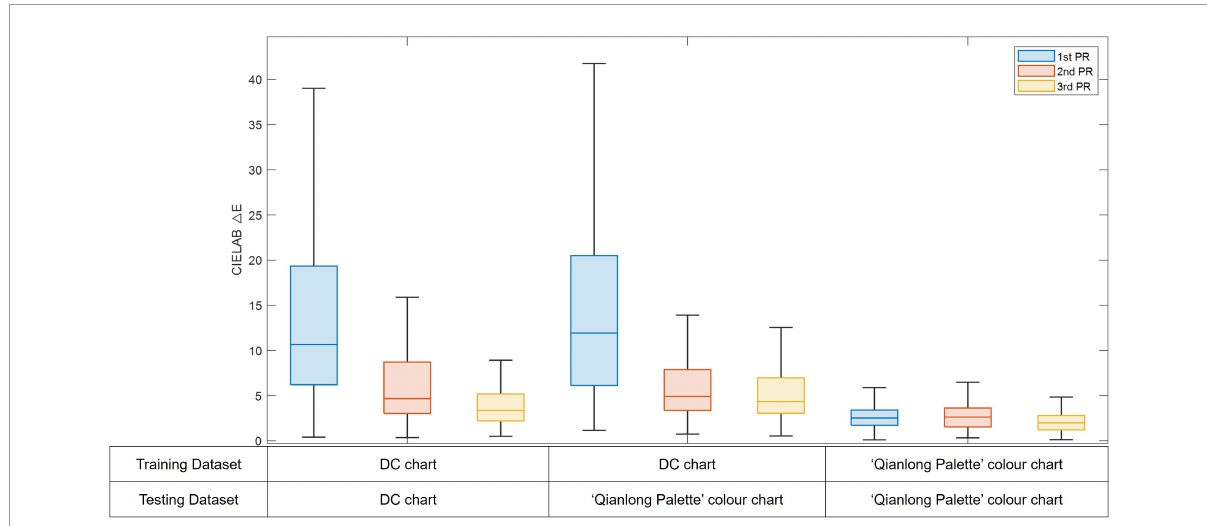
FIGURE6 The distribution of CIELAB color difference across all testing samples in different camera color characterization models (The line inside of each box is the median (cid:49) E ∗ ab ; the top and bottom edges of each box are the upper and lower quartiles, respectively; the whiskers are lines connect the maximum (cid:49) E ∗ ab and the minimum (cid:49) E ∗ ab ).